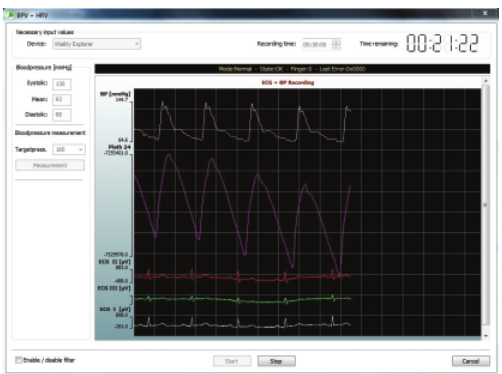
Figure 2: Synchronous ECG and blood pressure time series were continuously recorded and computer controlled.